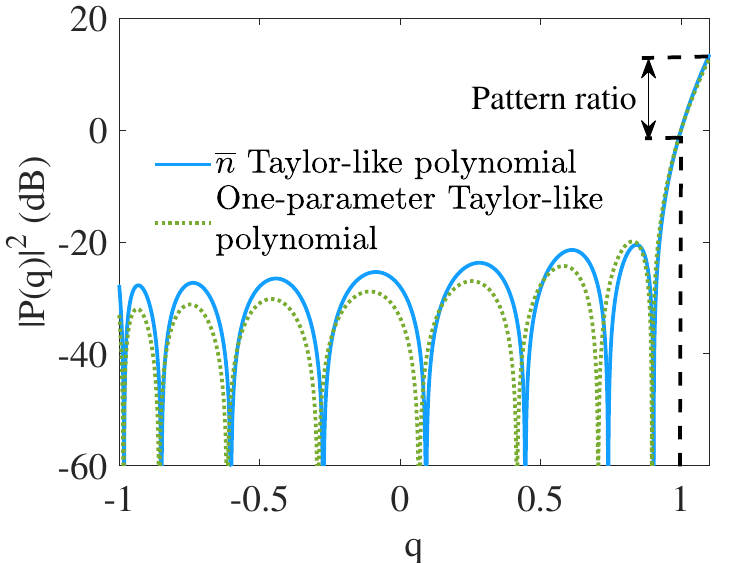
Figure 2. Comparison of the n (blue line) and the one-parameter (green dotted line) Taylor-like polyno- mials. The illustration of the pattern ratio (dB) defined by | P ( q ) | 2 ( dB ) − | P ( 1 ) | 2 ( dB ) = | P ( q ) | 2 ( dB )